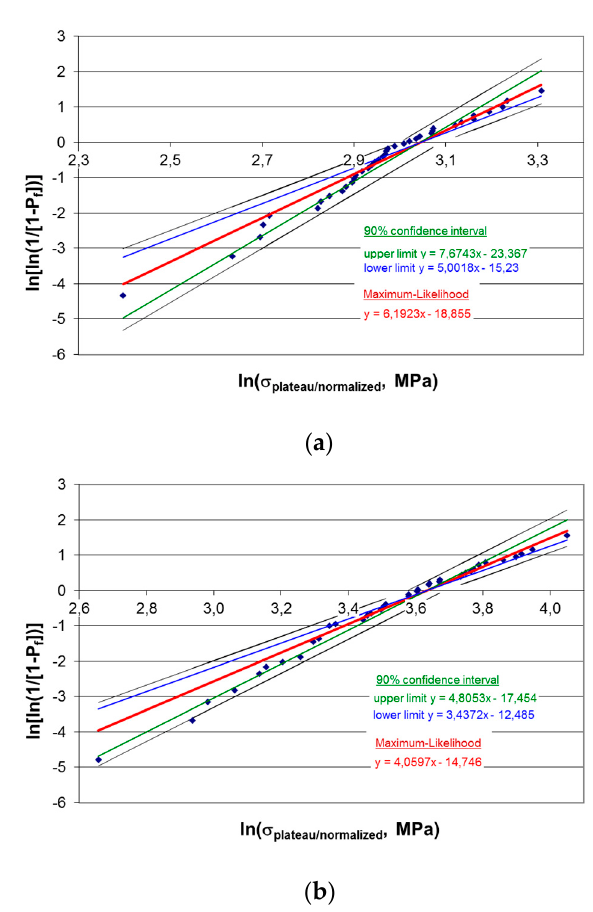
Figure 15. Compression test results—Weibull evaluation of plateau strength for AlSi7 with ( a ) and without TiB2 grain refiner ( b ), as-received TiH 2 as foaming agent.